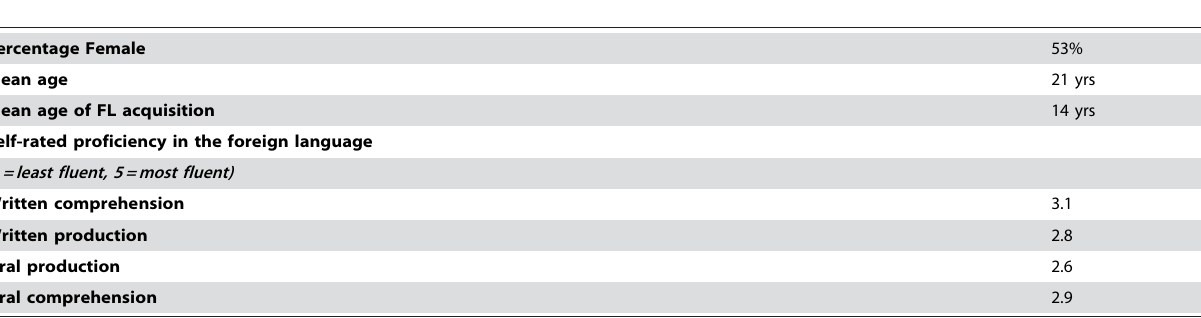
Table 1. Experiment 1 9 s participants’